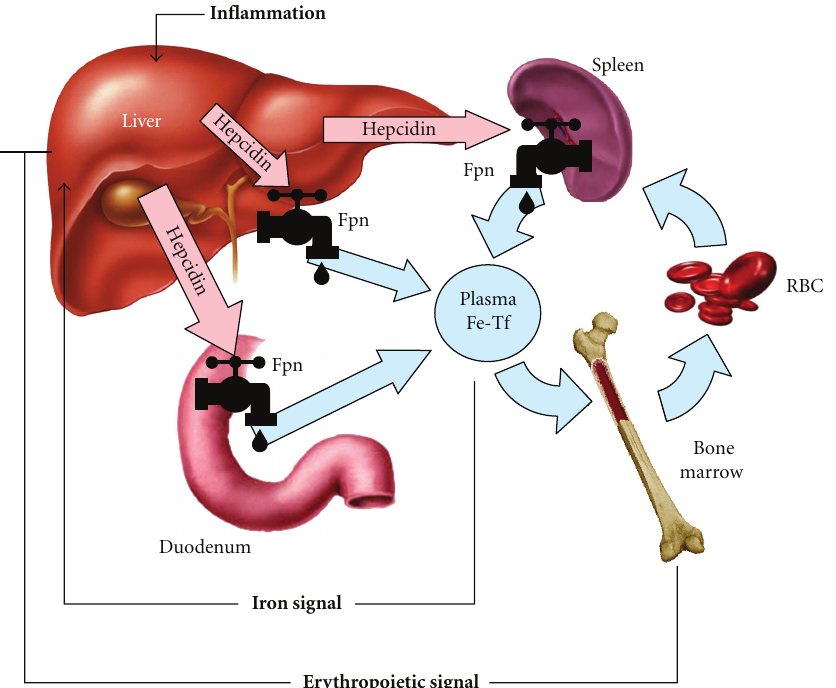
Figure 1: Hepcidin-ferroportin interaction determines the flow of iron into plasma. Hepcidin concentration is in turn regulated by iron, erythropoietic activity, and